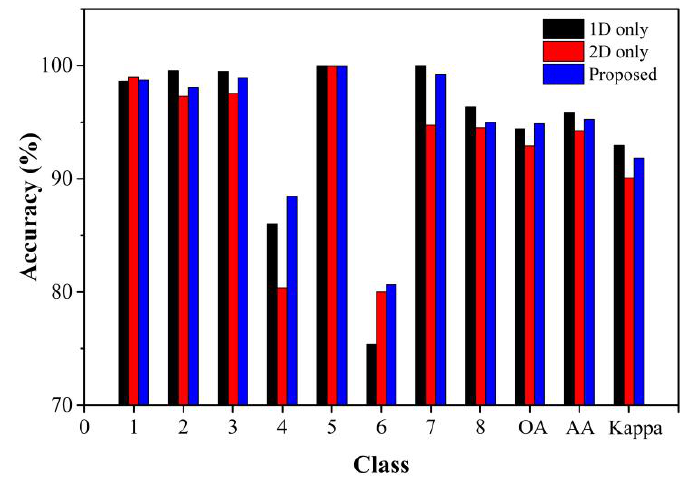
Figure 11. E ff ect of di ff erent model Figure 11. Effect of different model architecture.